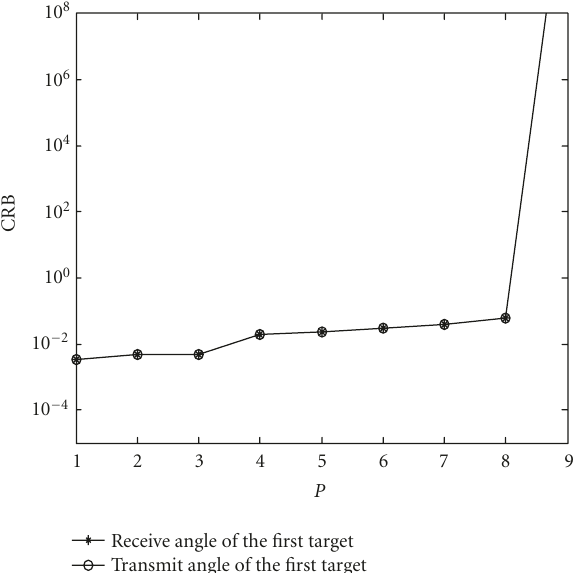
Figure 4: The CRB for MIMO radar of a single target with di ff erent = 0 . 1. Figure 5: CRB of the first target located at θ signals; θ t = 0 ◦ , θ r = 0 ◦ , σ 2 α